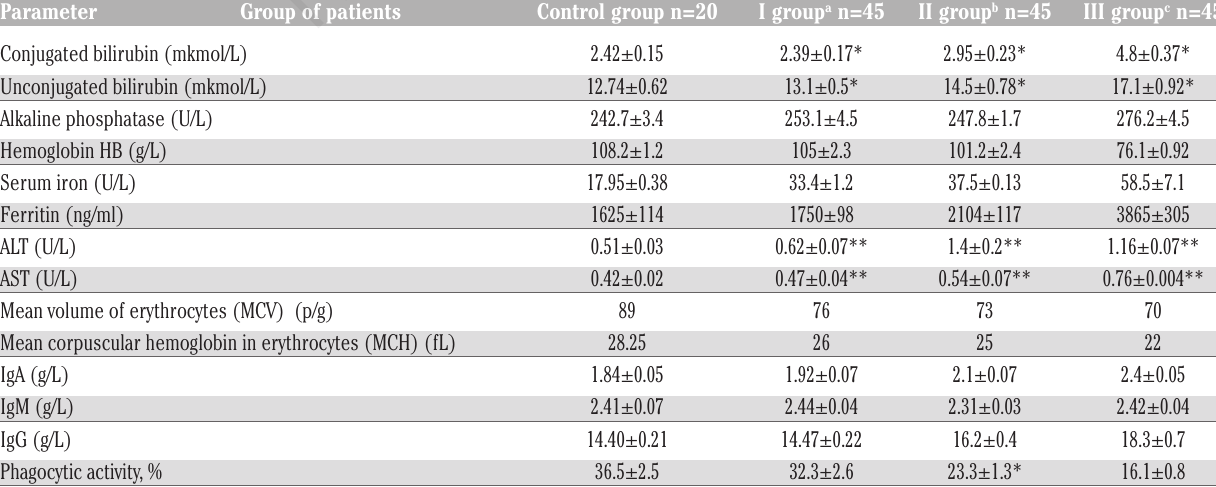
Table 1. Biochemical and immune parameters in patients with β -thalassemia.